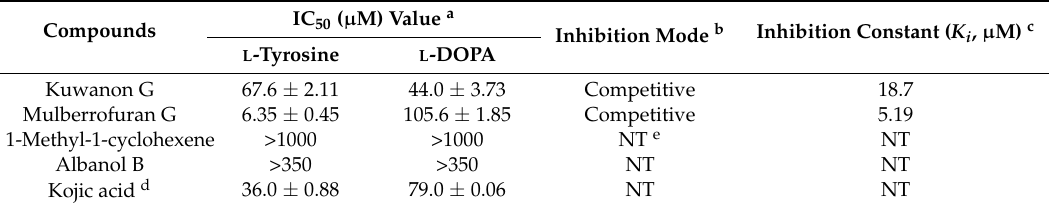
Figure 2. Concentration-dependent inhibition of kuwanon G, mulberrofuran G, and kojic acid on the activity of tyrosinase for the catalysis of L -tyrosine at 25 ◦ C. Table 1. Inhibitory activities of the compounds isolated from the root bark of Morus alba on mushroom